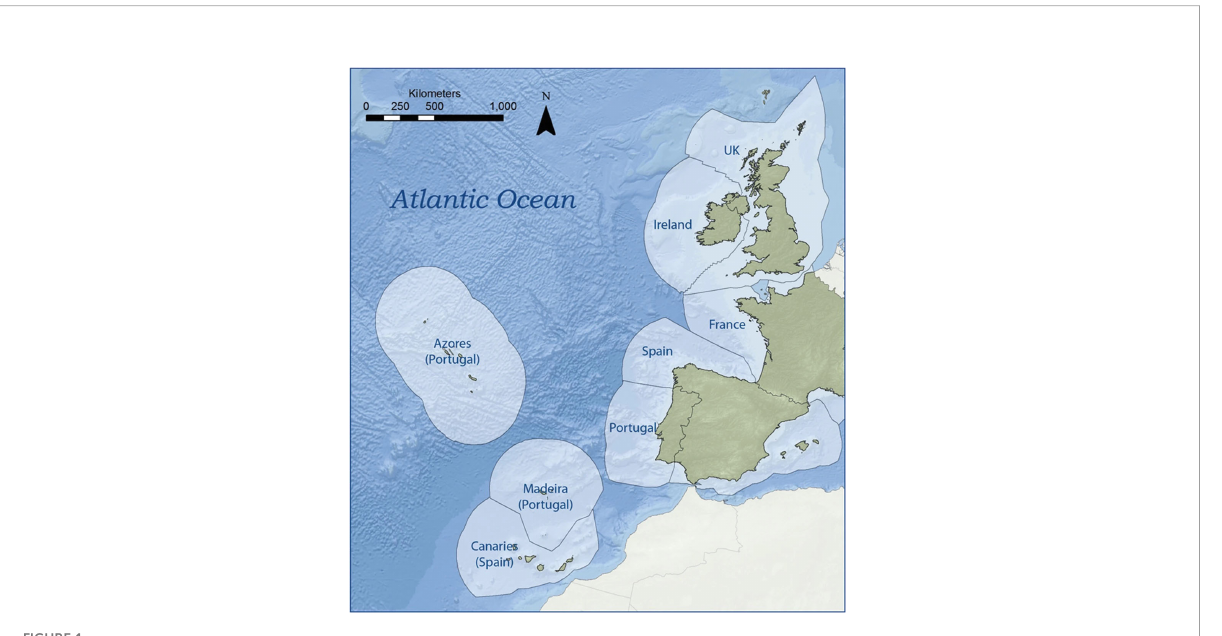
FIGURE 1 Location of the study area (Twomey and O ’ Mahony,